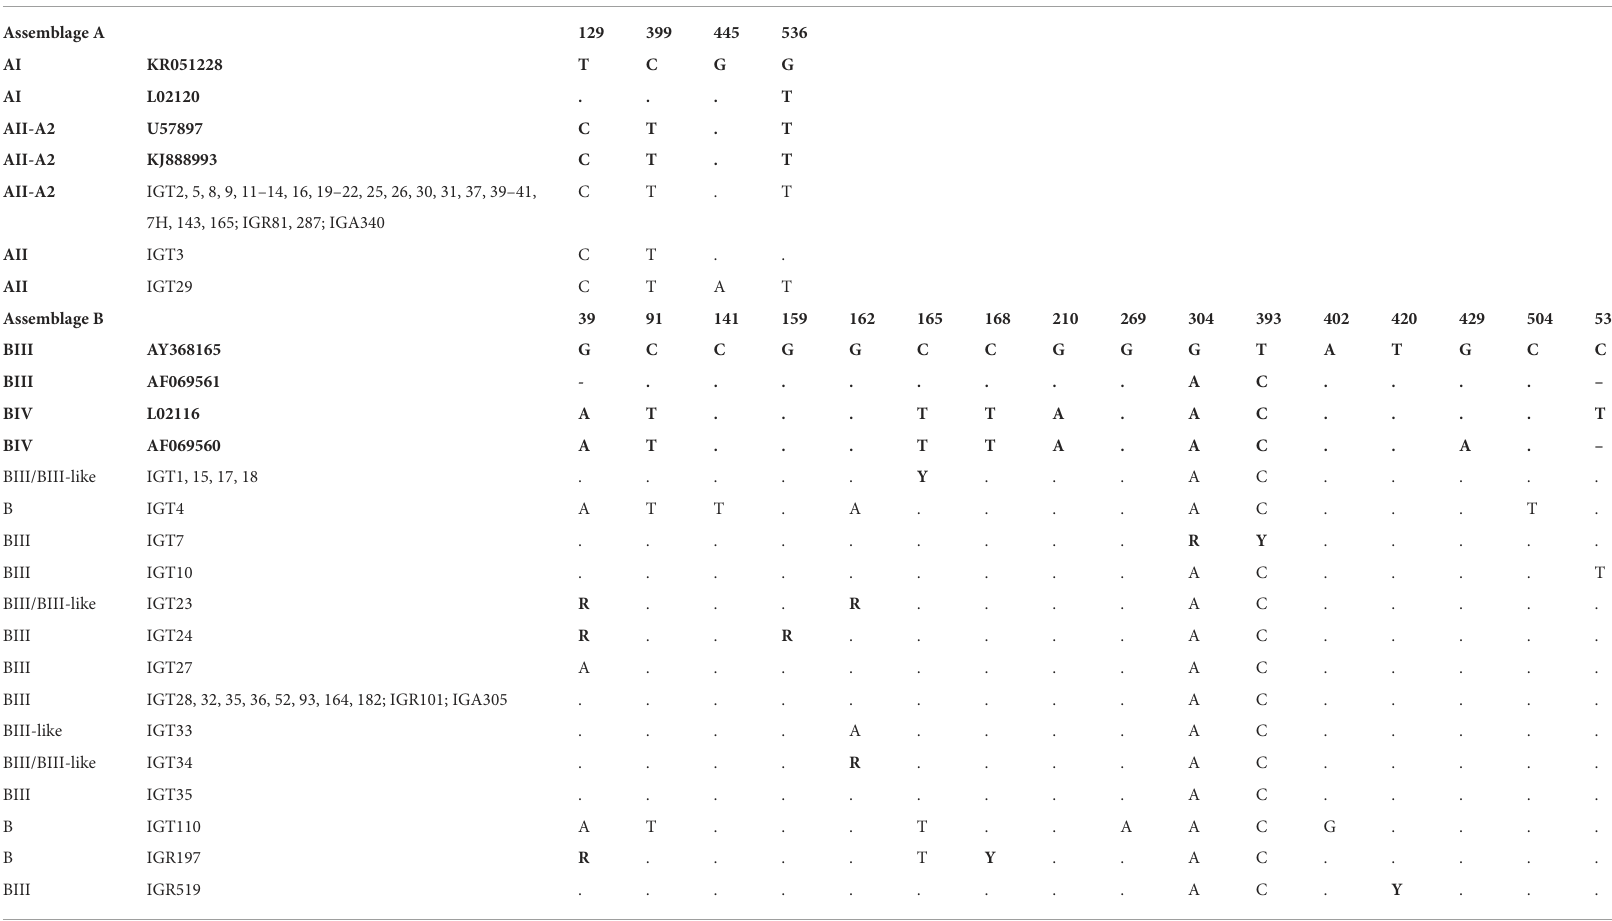
TABLE 4 Triosephosphate isomerase ( tpi ) multiple alignment sequence isolates in this study with reference sequences retrieved from GenBank, representing position of intra-genotypic substitutions in assemblages and sub-assemblages of assemblages A and B. Isolates/GenBank accession no.